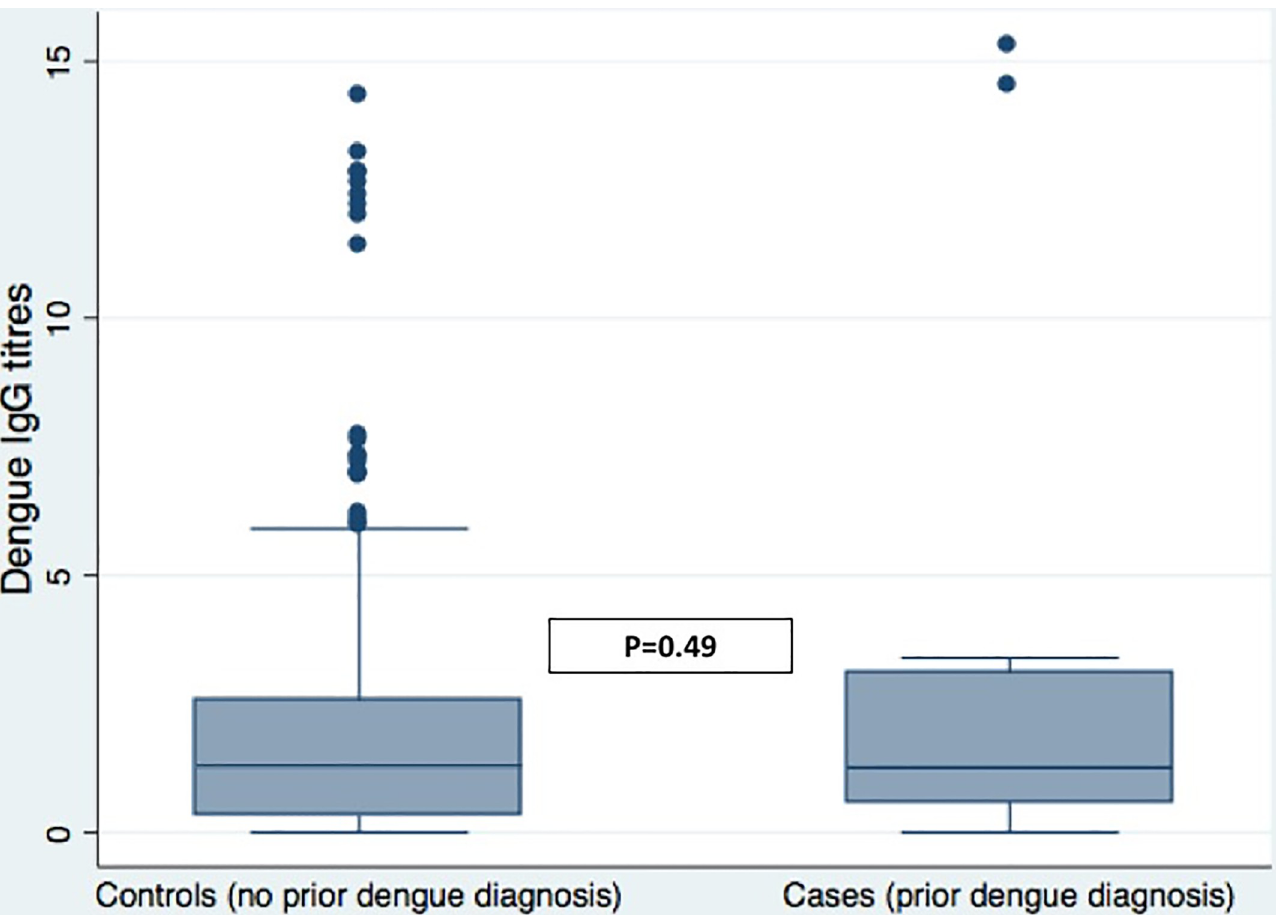
Fig 2. Comparison of the distribution of IgG dengue serology stratified by cases with medically confirmed dengue infection and controls with no medical diagnosis of dengue infection. The box plot shows the median value (central line in box) and the 25 th and 75 th percentiles (horizontal lines of box). The individual horizontal lines demonstrate the limits of adjacent data, and the dots represent the outlying values. Statistical comparison used the Mann-Whitney test.